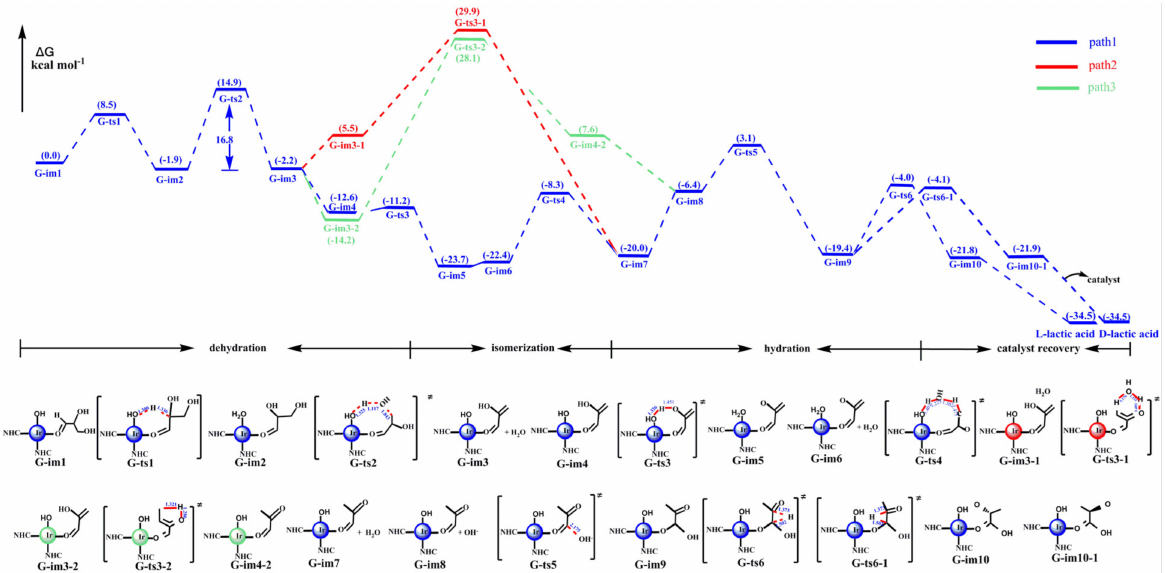
Figure 5. Energy profile for the dehydration and hydration reaction of 2,3-dihydroxypropanal to lactic acid catalyzed by the iridium–NHC with the coordinated